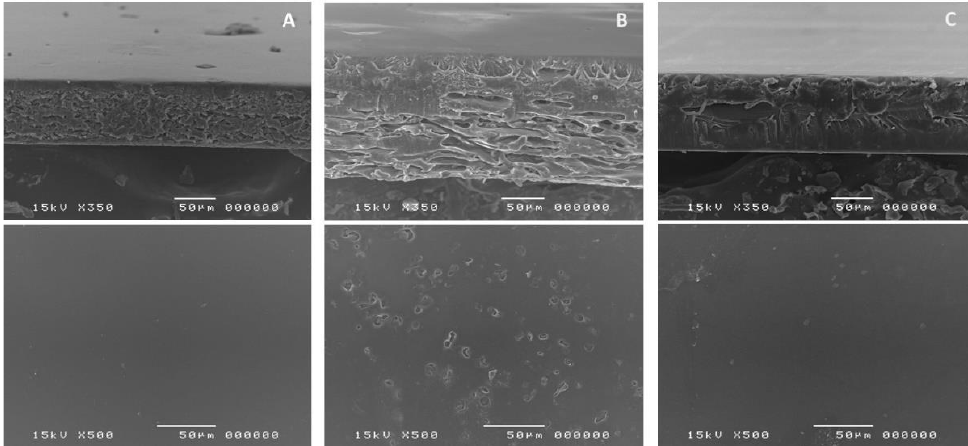
Figure 3. SEM images of the cross-sectional (top) and surface (bottom) of films. ( A )-HPMC LV5; ( B )-CLCMRS; ( C )-Composite HPMC: CLCMRS 83:17 (C-3) Film.